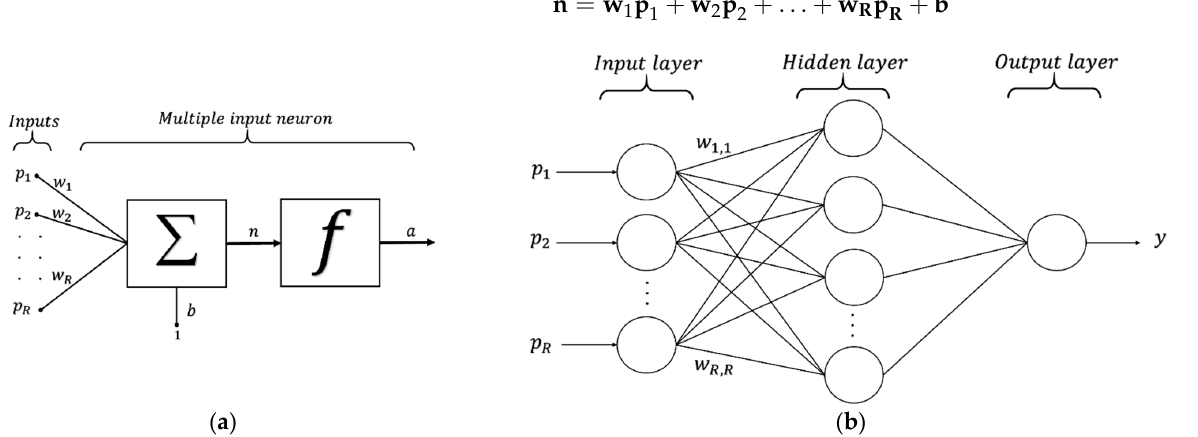
Figure 5. ( a ) A multiple input neuron; ( b ) Schematic diagram of the Multilayer Perceptron (MLP) neural network.